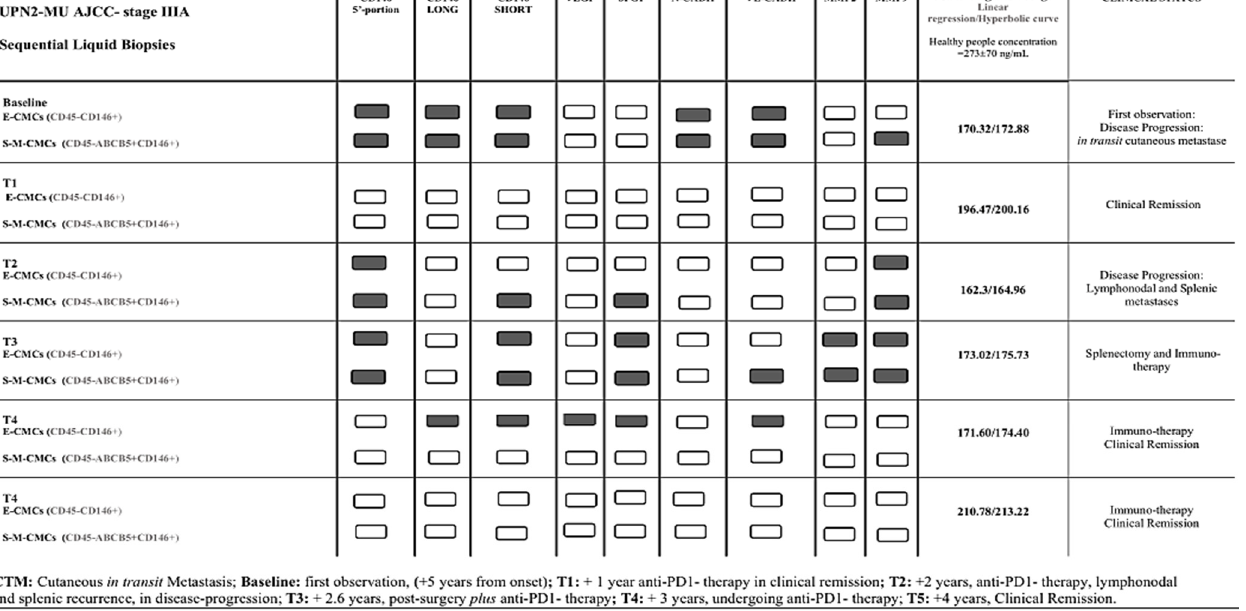
Figure 2. Specific patient’s molecular panel expression.